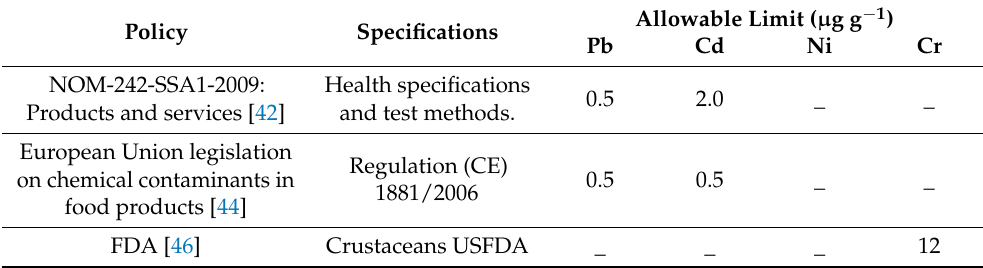
Table 2. Permissible concentration limits of toxic metals ( µ g g − 1 ) in crustaceans for human consump- tion to establish the risk to public